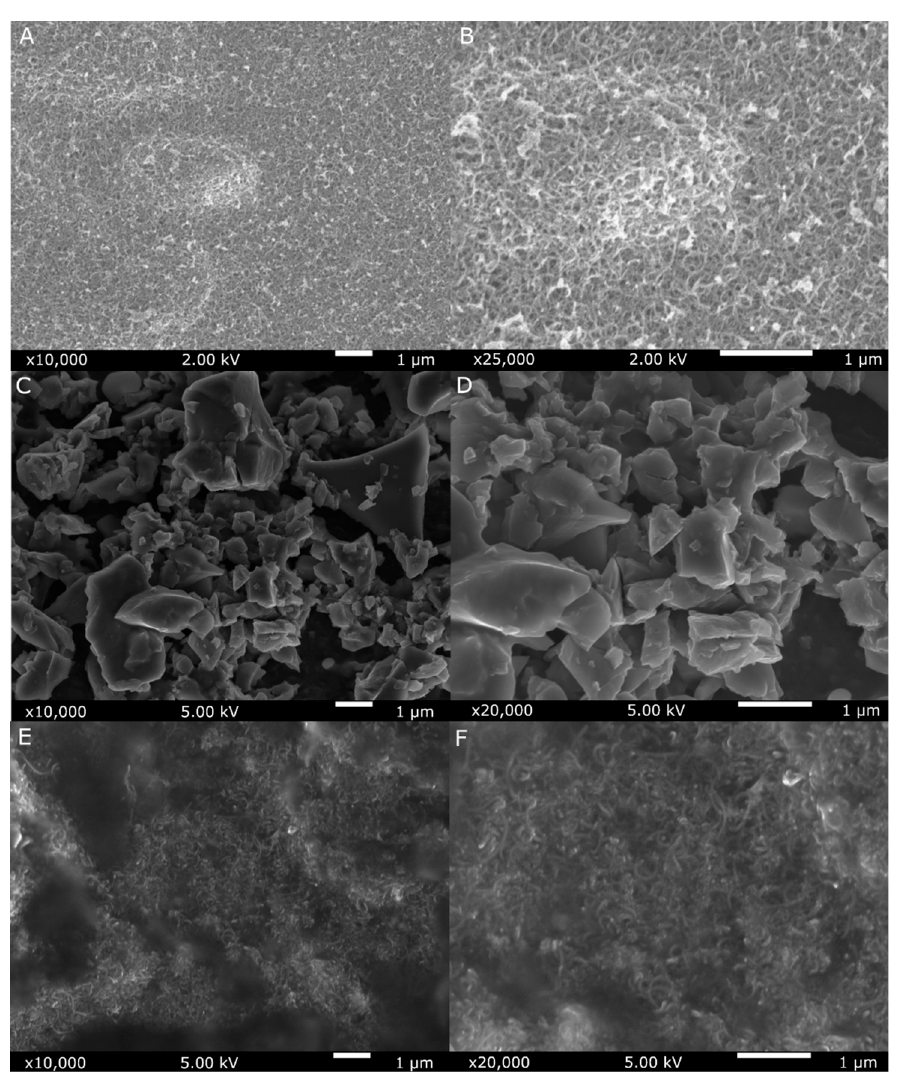
Figure 3. SEM surface topography of the MWCNTs coating ( A , B ), the MWCNTs/TiO 2 bi-layer coating ( C , D ), and the MWCNTs_Cu dispersion coating ( E , F ) at different resolutions.